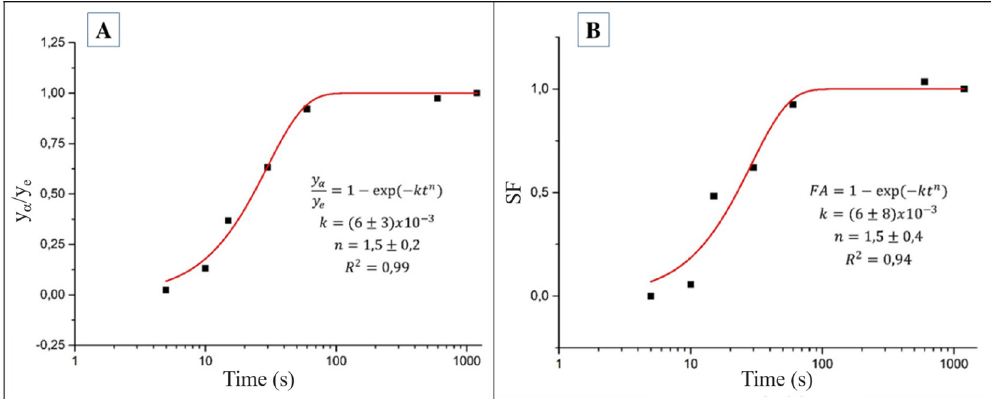
Figure 6. Fitting of JMAK model to the data obtained from: A) ferritic phase fraction as a time function; B) Vickers microhardness as a time function. Step at 700°C.